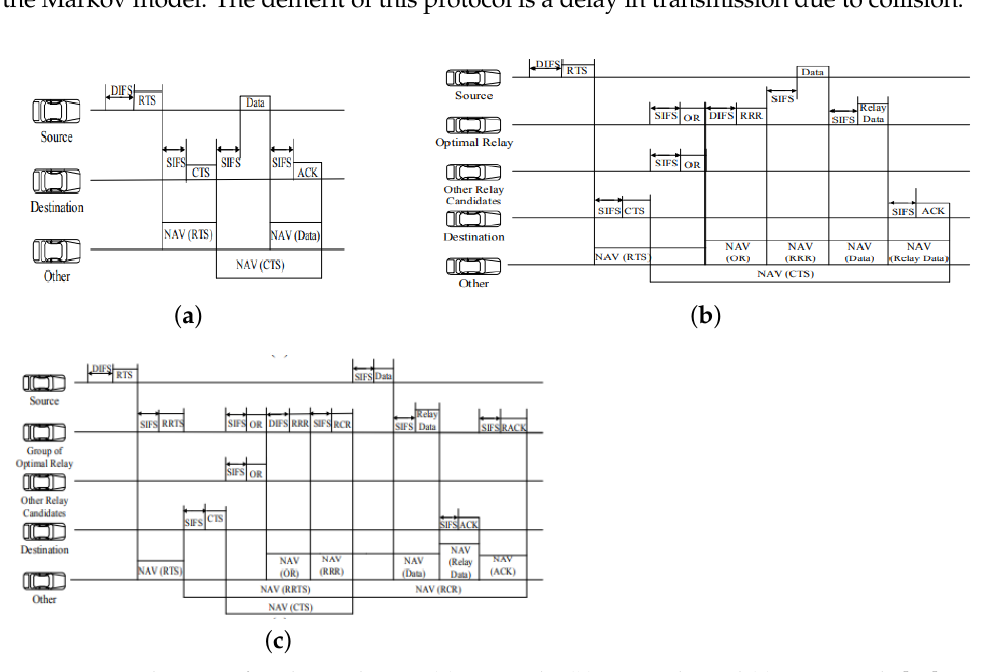
Figure 12. Mechanism of packet exchange: ( a ) DT mode, ( b ) CR mode, and ( c ) MHR mode